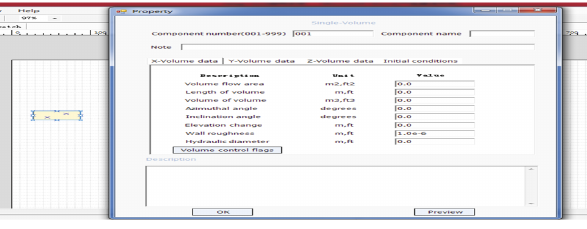
Figure 6: Single volume parameter input interface.